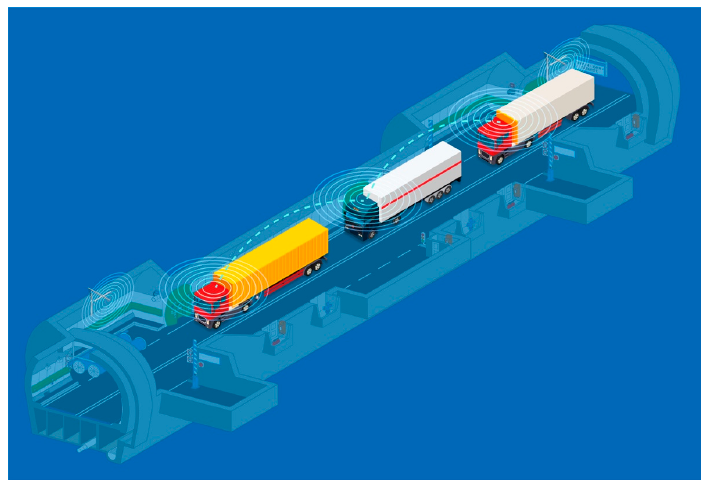
Figure 2. V2X Platooning